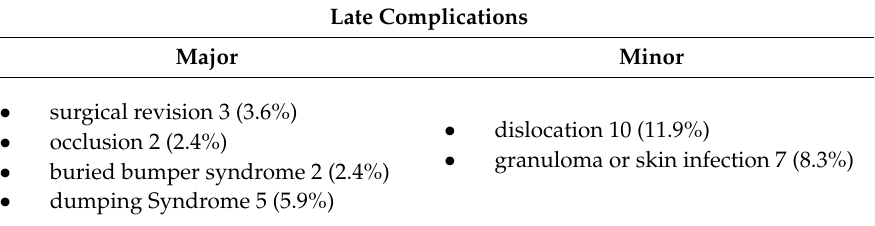
Table 2. Late complications of gastrostomy tube